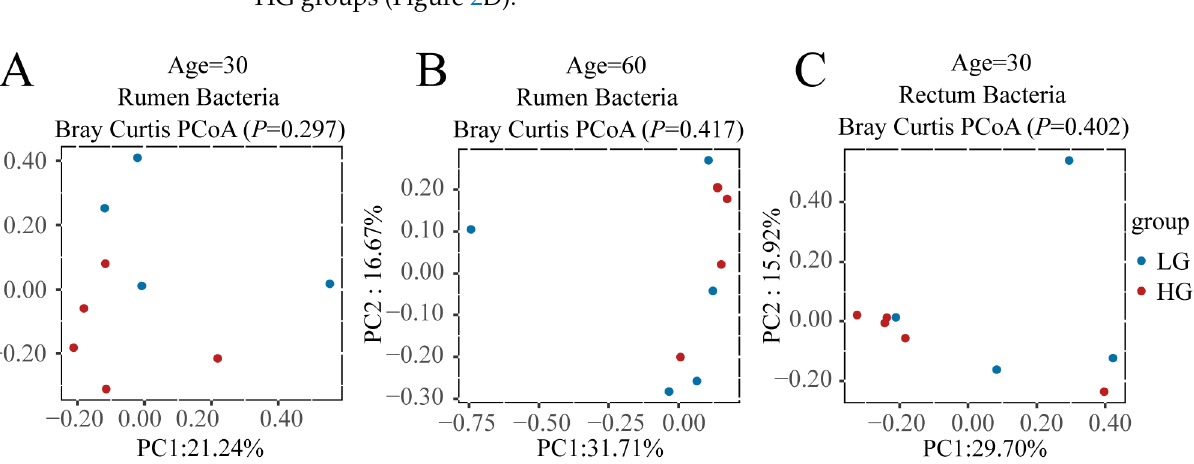
Figure 2. Bacterial and fungal communities and differences between the five lambs with the lower average daily gain (LG) and the five lambs with the higher average daily gain (HG) in the gastroin- testinal tract before weaning. ( A ) Principal coordinate analysis (PCoA) plots of the rumen bacterial communities of LG and HG groups at 30 days of age before weaning. ( B ) PCoA plots of the rumen bacterial communities of LG and HG groups at 60 days of age before weaning. ( C ) PCoA plots of the rectum bacterial communities of LG and HG groups at 30 days of age before weaning. ( D ) PCoA plots of the rectum bacterial communities of LG and HG groups at 60 days of age before weaning. ( E ) PCoA plots of the rumen fungal communities of LG and HG groups at 30 days of age before weaning. ( F ) PCoA plots of the rumen fungal communities of LG and HG groups at 60 days of age before weaning. ( G ) PCoA plots of the rectum fungal communities of LG and HG groups at 30 days of age before weaning. ( H ) PCoA plots of the rectum fungal communities of LG and HG groups at 60 days of age before weaning.